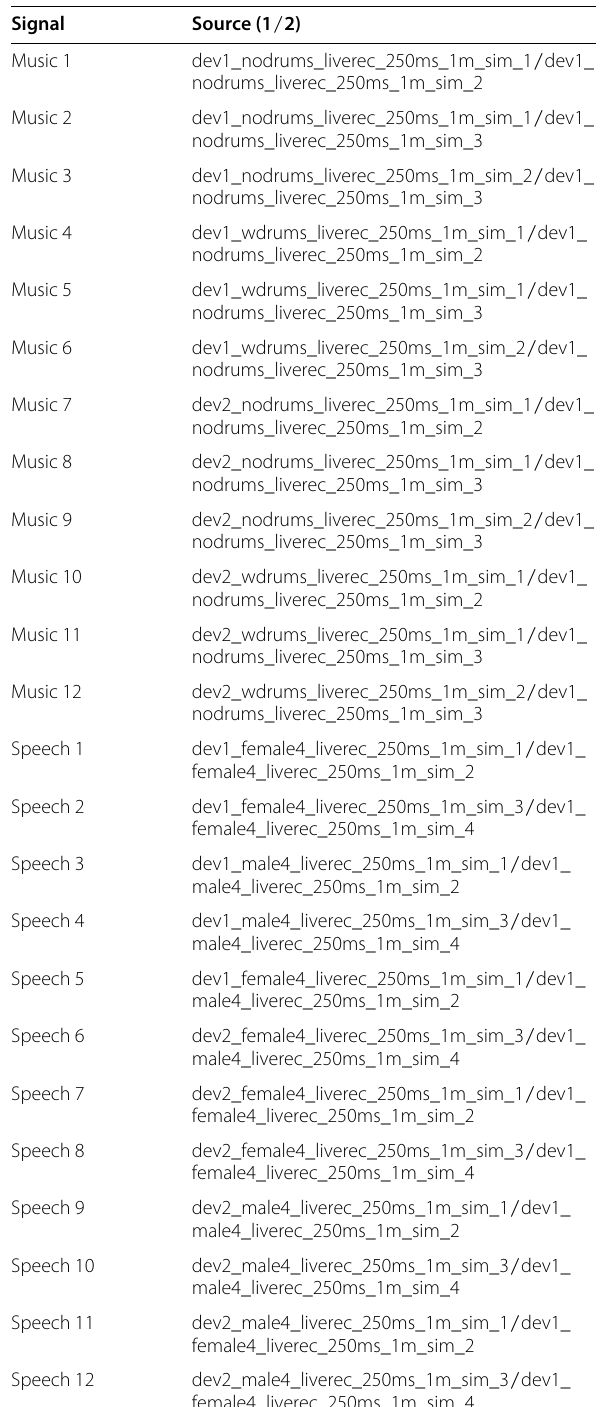
Table 3 Live-recorded music and speech signals obtained